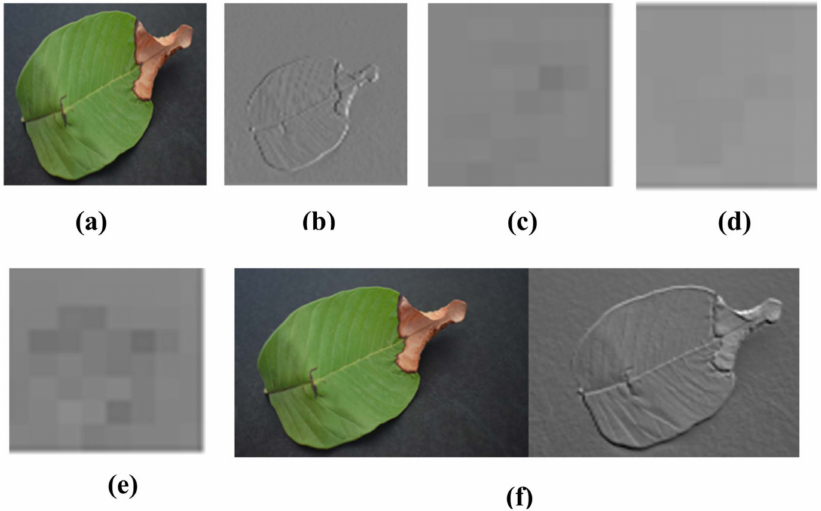
Figure 5. Visualization of the images of strong feature maps of different convolution layers of DarkNet-53. ( a ) conv3 ( b ) conv1 ( c ) conv2 ( d ) conv4 ( e ) conv5 ( f )